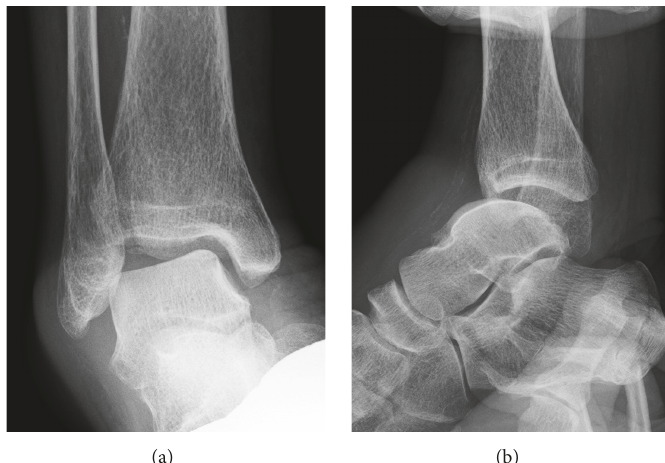
Figure 2: (a) Varus stress view of the ankle showing the talar tilt of 15 degrees. (b) Anterior drawer stress view of the ankle showing marked anterior displacement of the talus.